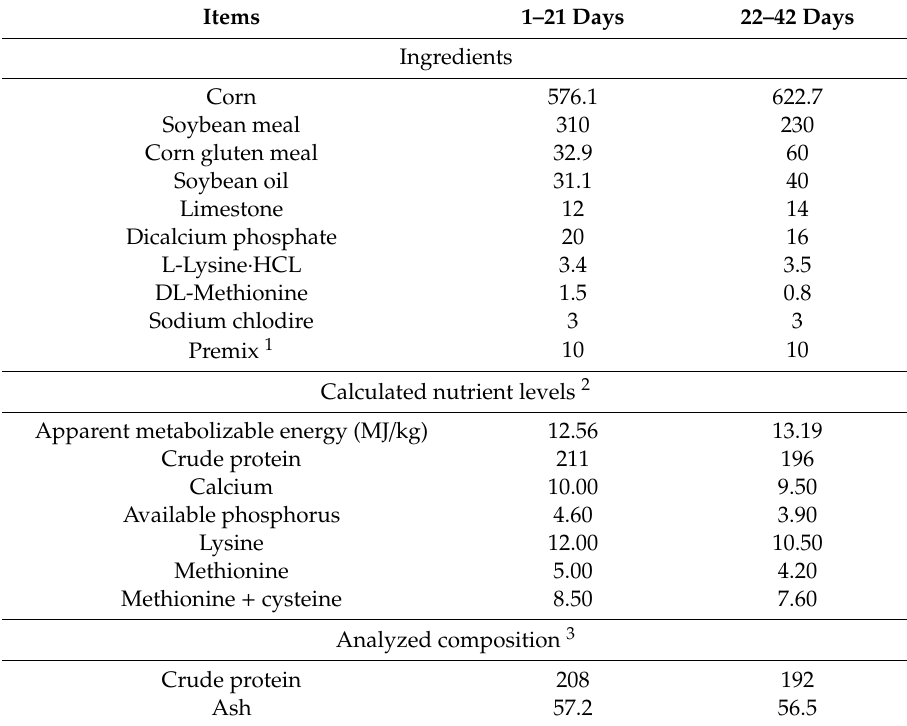
Table 1. Composition and nutrient level of basal diet (g / kg, as-fed basis unless otherwise